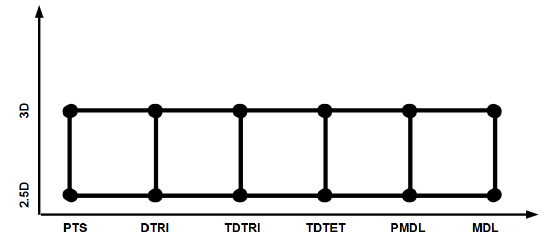
Figure 1: Layout of nodes and edges for creating Hamiltonian Paths